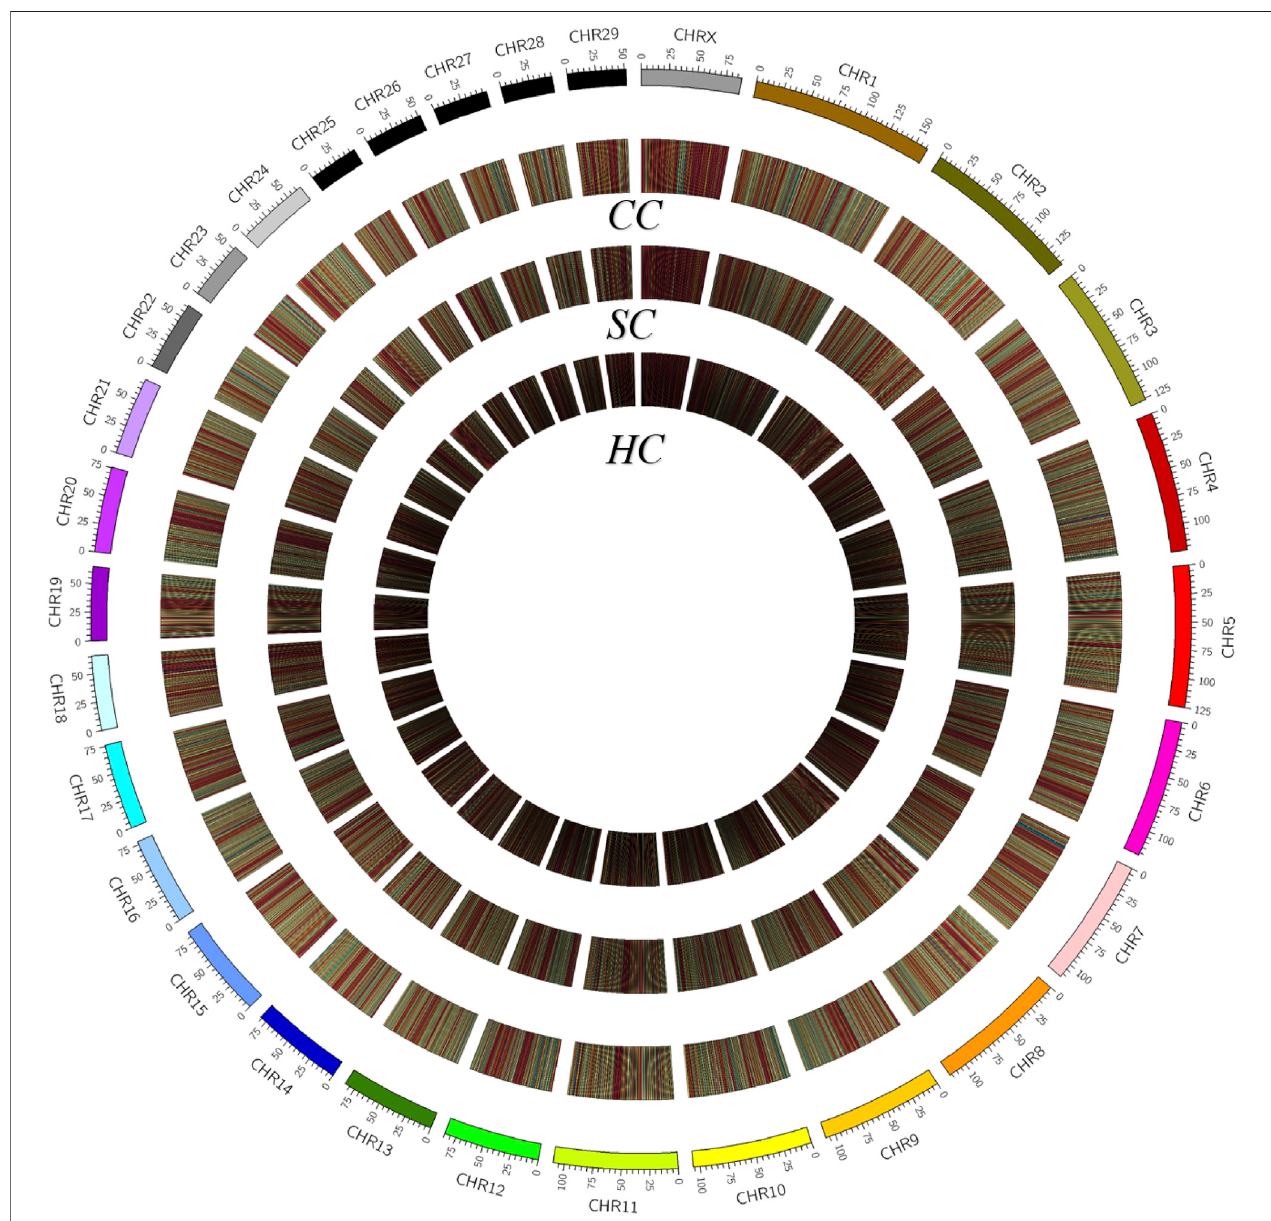
FIGURE 2 | Density plot of 5-methylcytosine among various groups. Chromosome numbers and scales are indicated on the periphery, a dark to light color indicates a low to high level of methylation. CC: clinical cow; SC: subclinical cow; and HC: healthy cow.